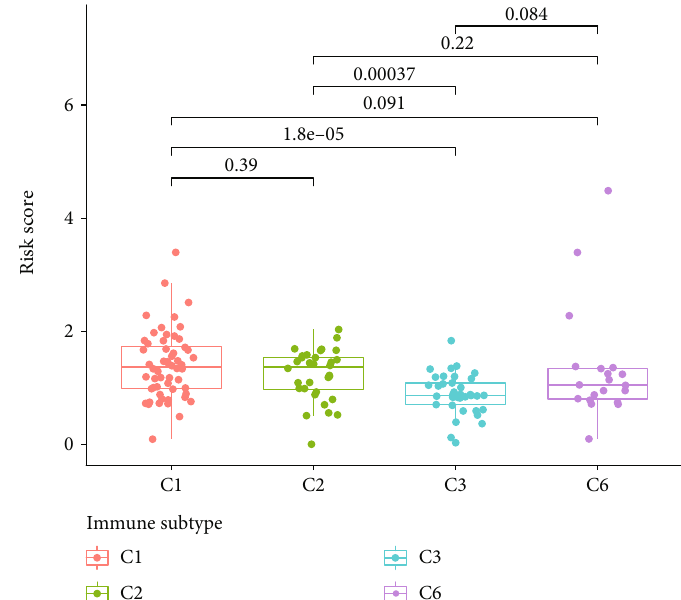
Figure 8: A high risk score was found to be related to C1, whereas a low risk score was related to C3 in our study of immune in fi ltration of PAAD in PAAD